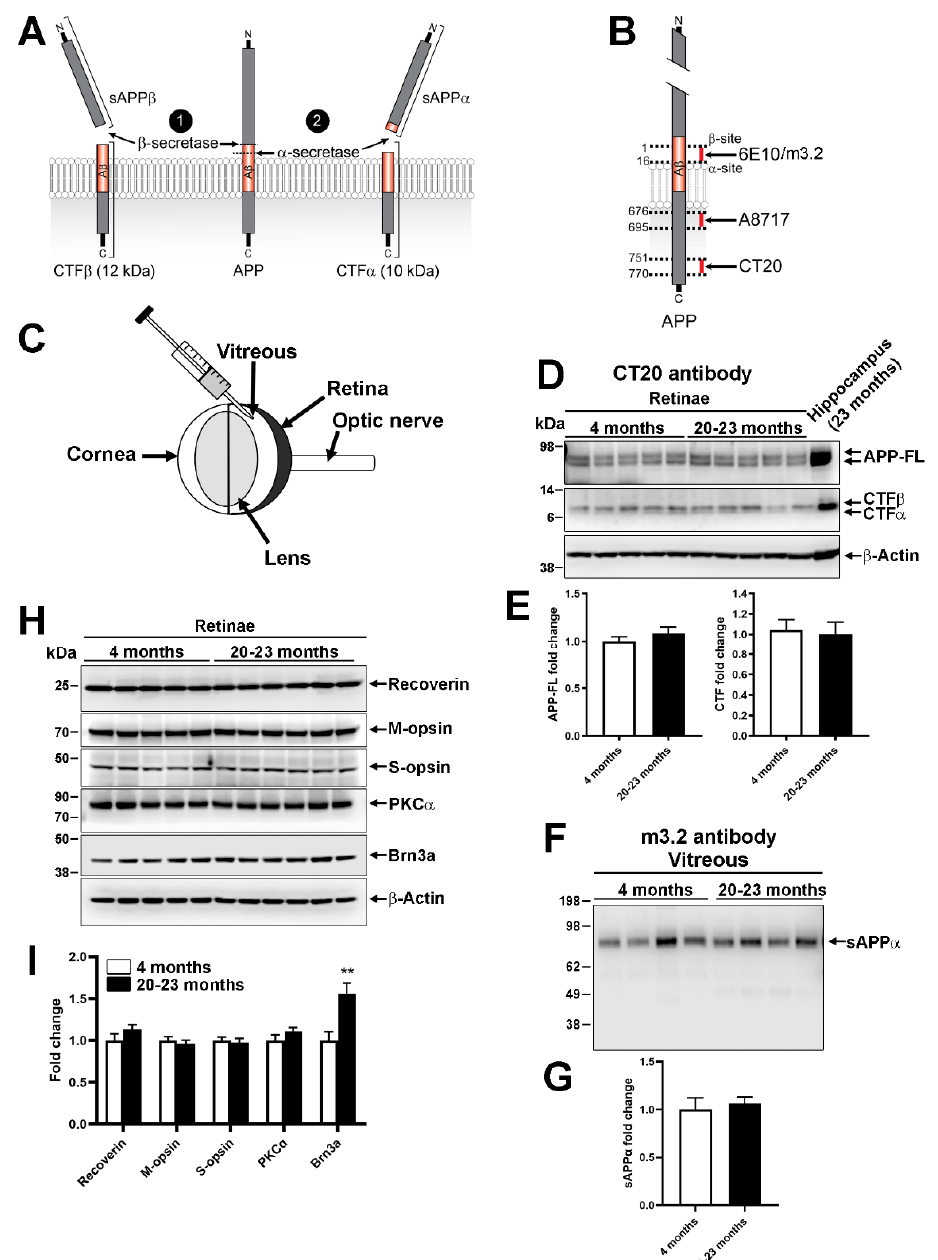
Figure 2. Expression of constitutive retinal proteins and amyloid precursor protein products in old vs. young WT mice. ( A ) Scheme showing possible amyloid precursor protein (APP) processing in neurons. ( B ) APP epitopes recognized by antibodies in Western blot analyses. ( C ) Mouse eye anatomy. The retina and vitreous were separately processed for APP fragment detection by Western blotting. ( D , E ) Detection of full-length APP (APP-FL) and C-term fragment alpha (CTF α ) and beta (CTF β ) in retinal lysates. Five animals per age were examined. Densitometric quantifications of bands in ImageJ software (NIH) did not reveal protein expression change between the two age groups. ( F , G ) sAPP α release in 4 μ L of mouse vitreous was analyzed in the same mice. Quantitative analysis did not show significant difference. ( H , I ) The level of proteins expressed in the different retinal cell layers did not significantly vary along with age except that of Brn3a, which was statistically higher in old retinae than in young ones (unpaired t -test, **: p < 0.01). Cartoons presented in ( A , B ) are from [8].